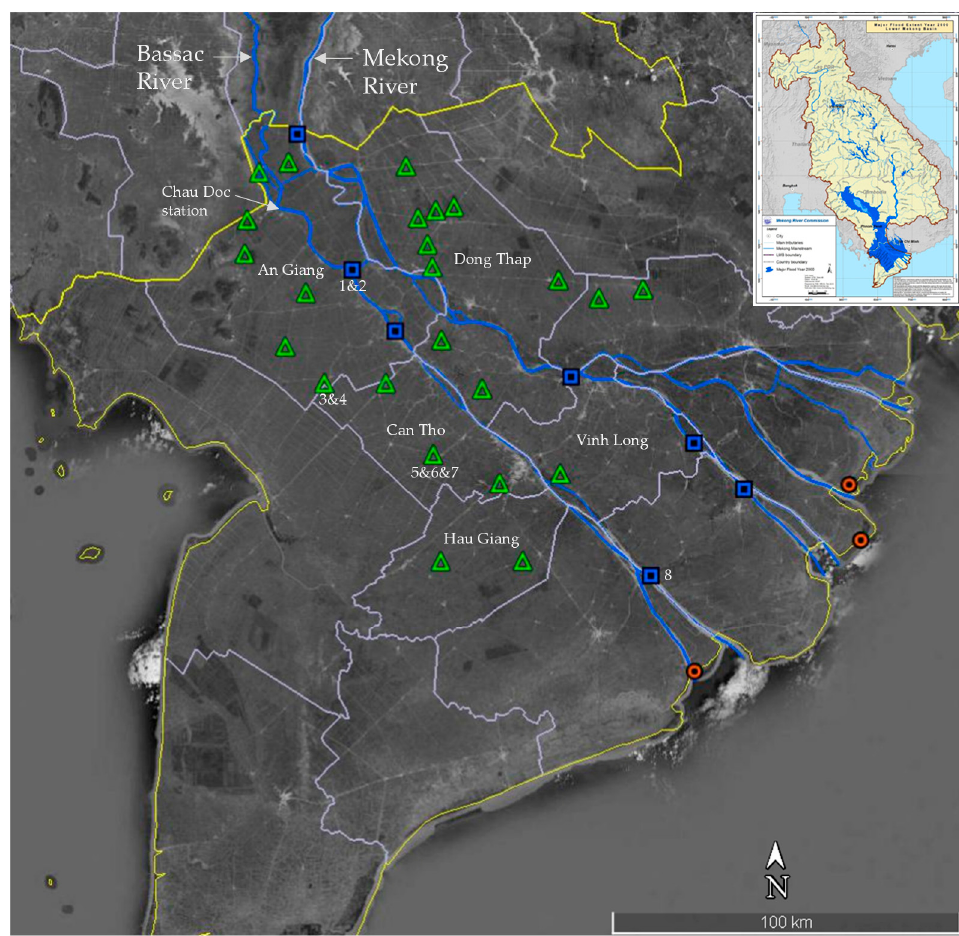
Figure 2. Study sites in the Mekong Delta of Vietnam (triangle symbols: tributaries sites; square symbols: main stem sites; and circle symbols: coastal sites); numbers (1 to 8) next to symbols indicating eight fishers under the catch monitoring program of RIA2/MRC. The small top-right map shows the major flood zone (blue) of the Lower Mekong Basin.